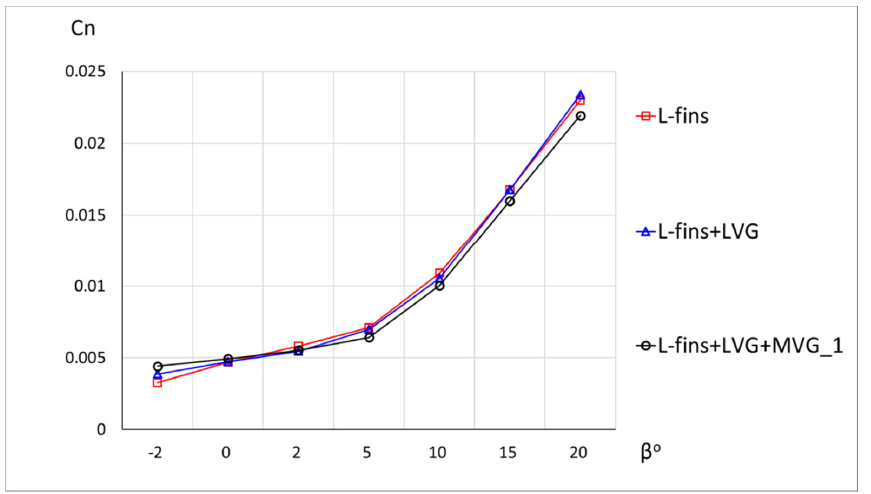
Figure 18. Yaw moment coefficient of the model equipped with combinations of L-fins, LVG, and MVG_1.